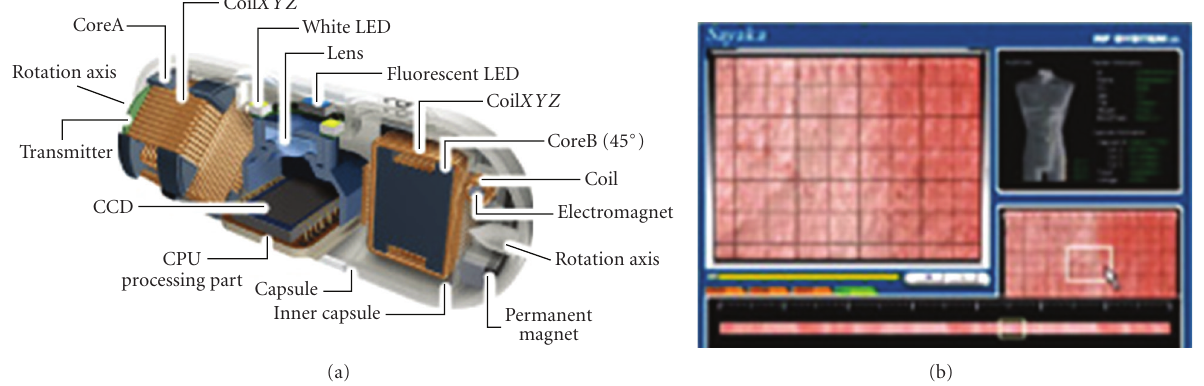
Figure 5: Sayaka CE. Vision is lateral; therefore snapshots are taken while rotating and are composed in mosaic. It is from http://www.rfamerica.com/sayaka/.